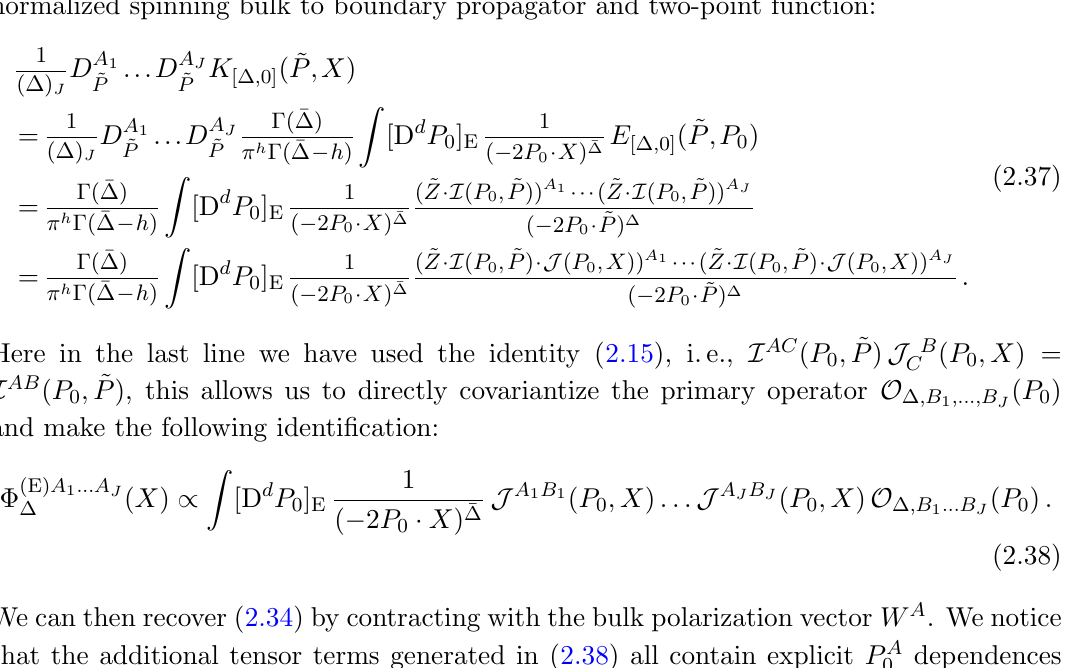
(cid:1) ;J to the point X ( (cid:21) ) [(cid:1) ; 0]